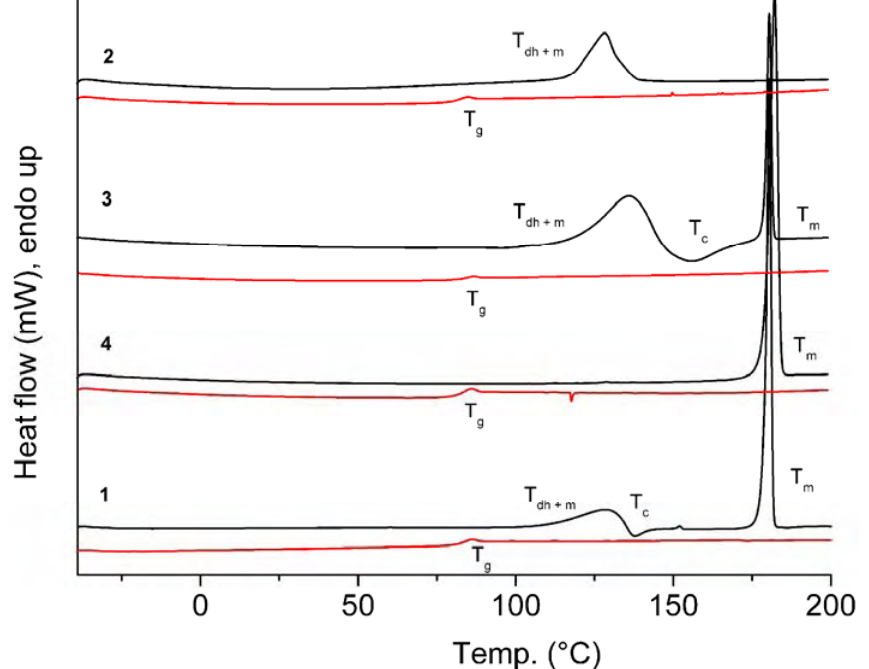
Figure 8. DSC scans of solids 1 – 4 . On each pair of scans: first heating scan is on